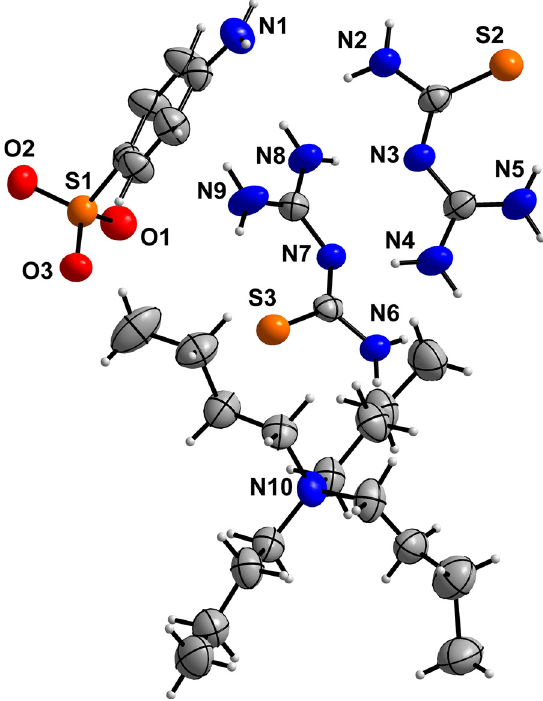
Table  : Data collection and